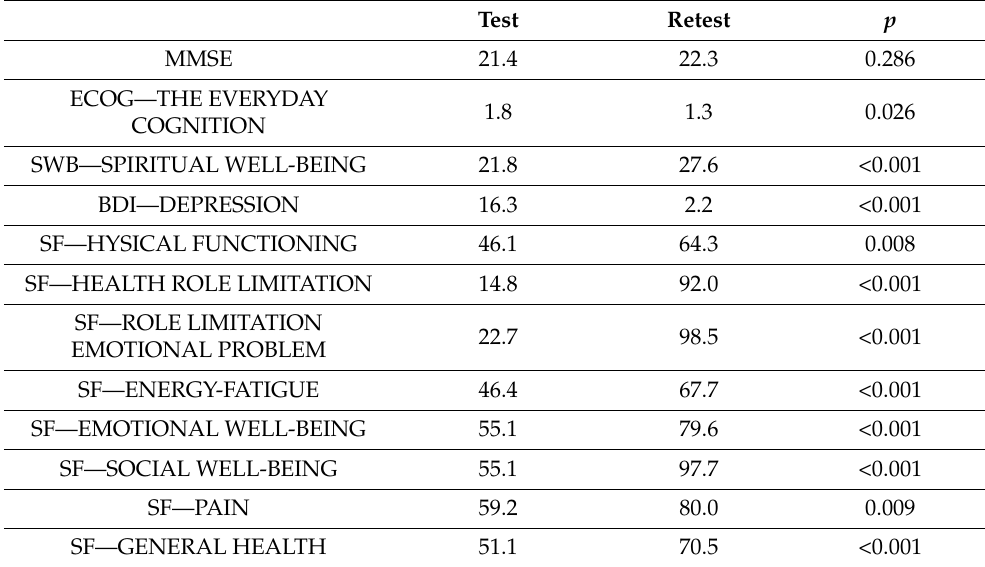
Table 2. Mindfulness-Patients: Evaluation of quality of life, depression, and MMSE (T0–T1 six months).